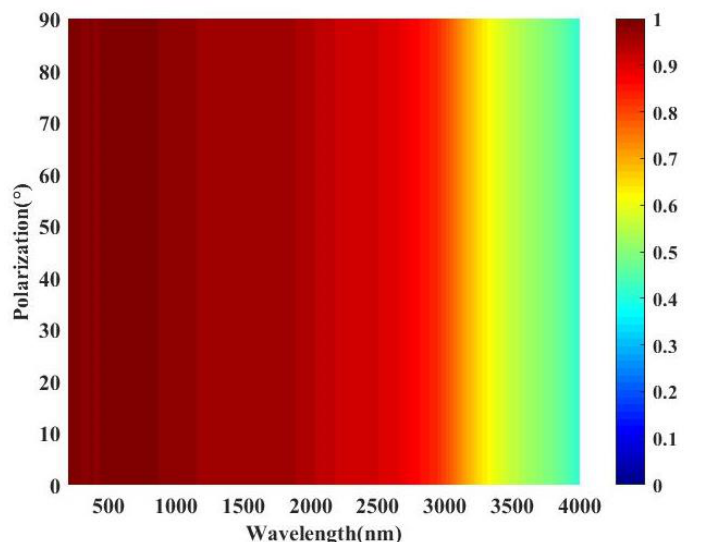
Figure 6. Absorption map of the proposed solar energy absorber with different polarization angles under normal